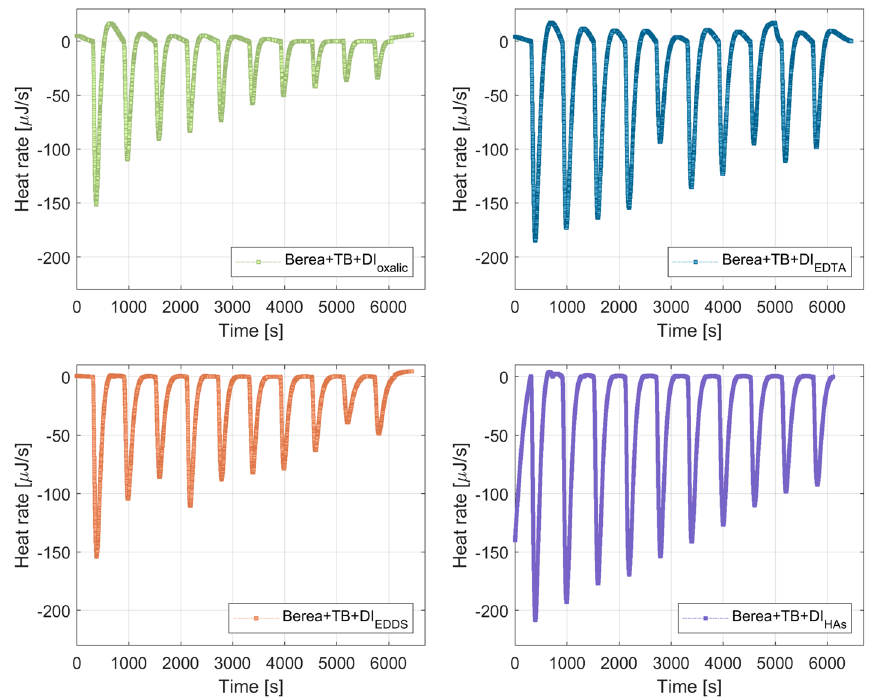
Fig. 6 Thermograms for the interaction of DI chelating and Berea